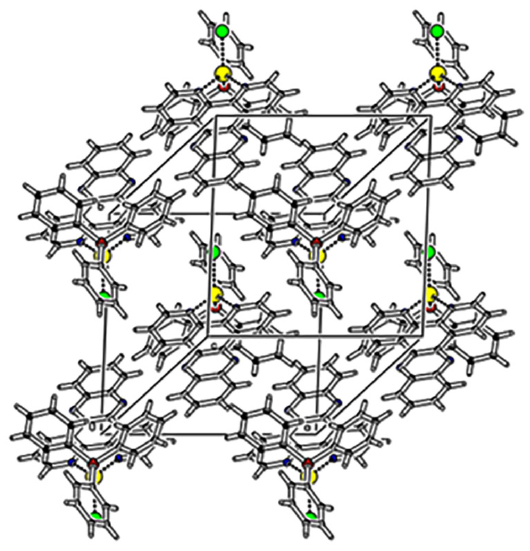
Figure 4. Unit cell packing diagram for Cu-1